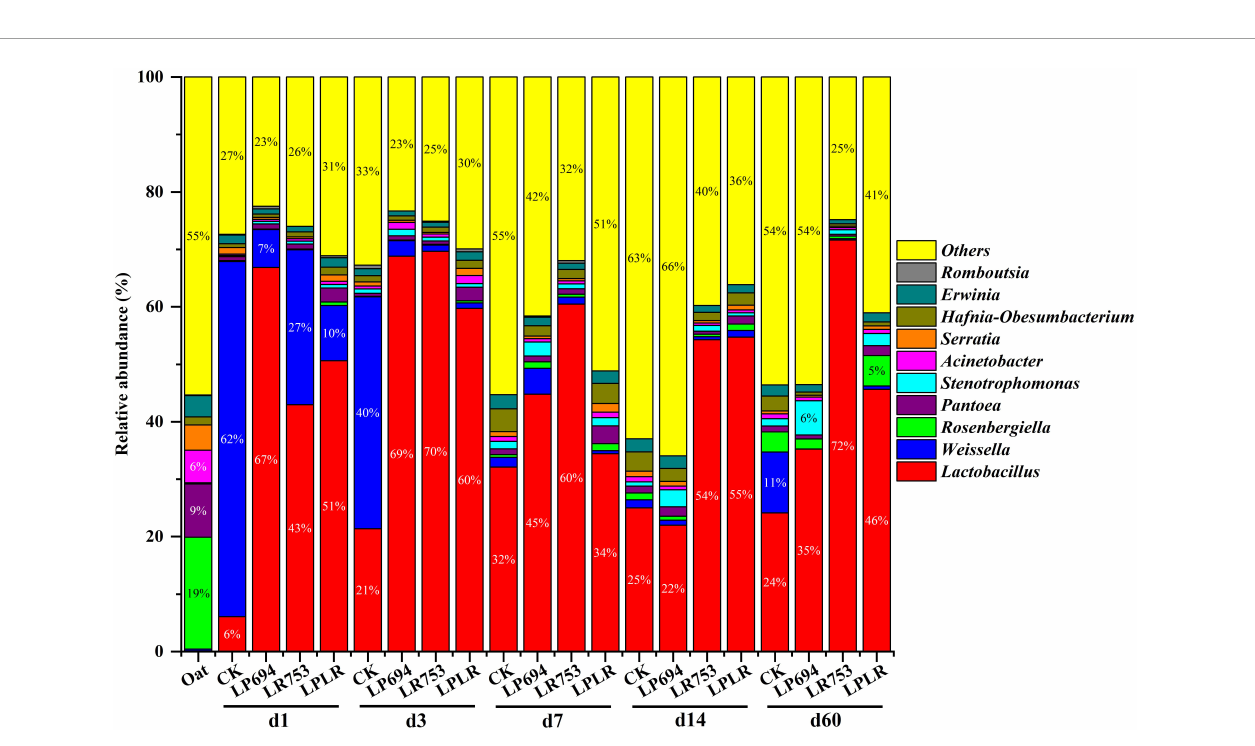
FIGURE2 Relative abundance of bacteria at the genus level for oat silages at different days of ensiling with and without lactic acid bacterial inoculation. CK, sterilized water; LP694, Lactobacillus plantarum 694; LR753, Lactobacillus rhamnosus 753; LPLR, 50% LP694 + 50% LR753; d, ensiling days; OAT.F, fresh